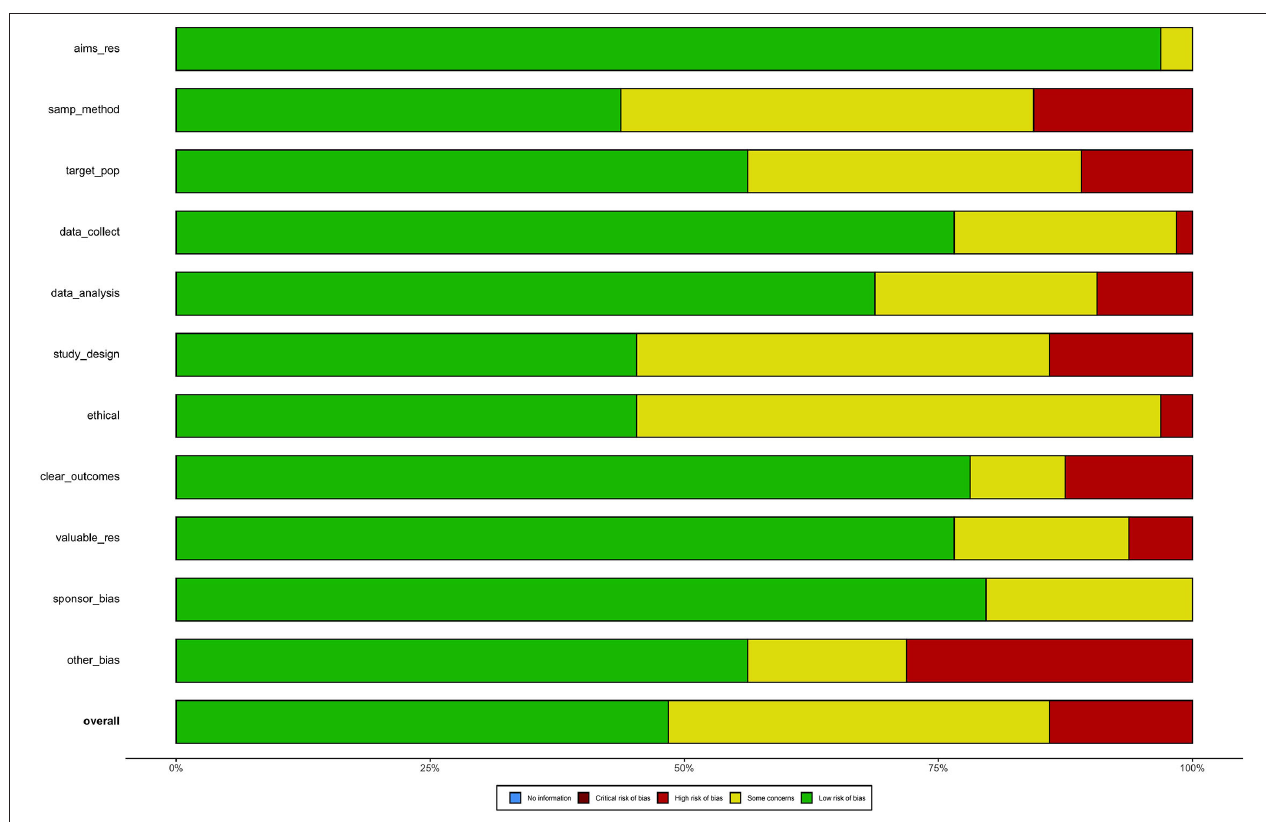
FIGURE 3 | Plot showing risk of bias weights by authors judgement. The weighted plots show proportion of information with each judgement within each domain. Supplementary Table S1 explains the legend on the y -axis.